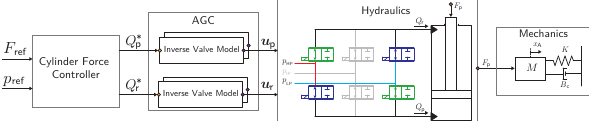
Figure 8: Schematic of the simplified hydraulic system to be controlled.